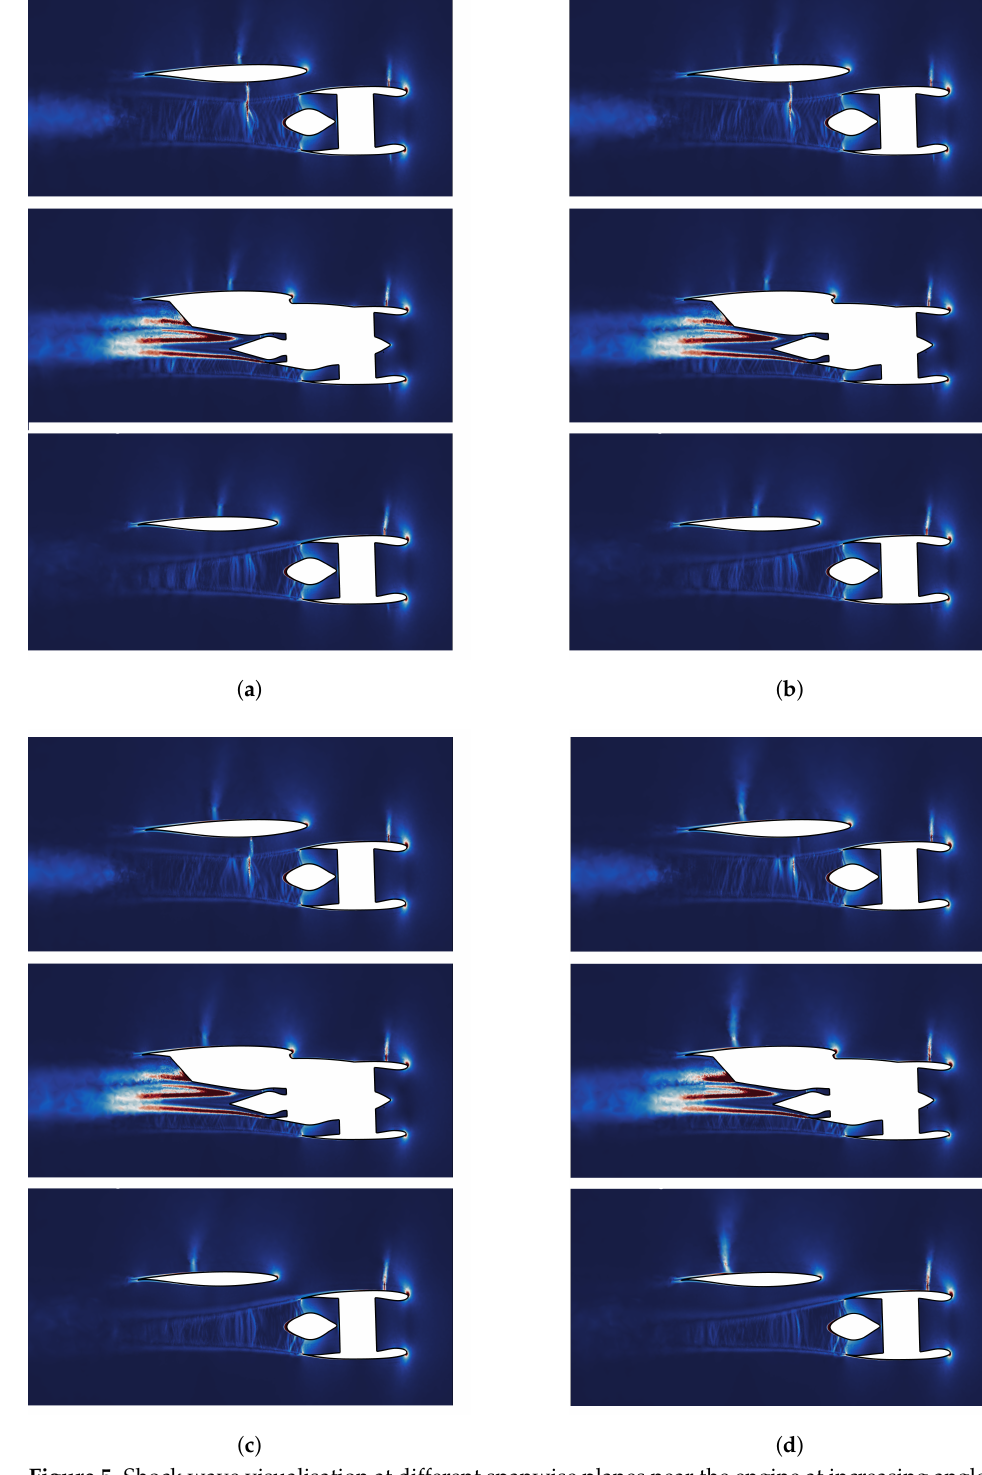
Figure 5. Shock wave visualisation at different spanwise planes near the engine at increasing angle of attack by means of density gradient contours. From top to bottom: inboard, nacelle symmetry plane, outboard. ( a ) α = 2 ◦ ; ( b ) α = 2.23 ◦ ; ( c ) α = 3 ◦ ; ( d ) α = 4 ◦